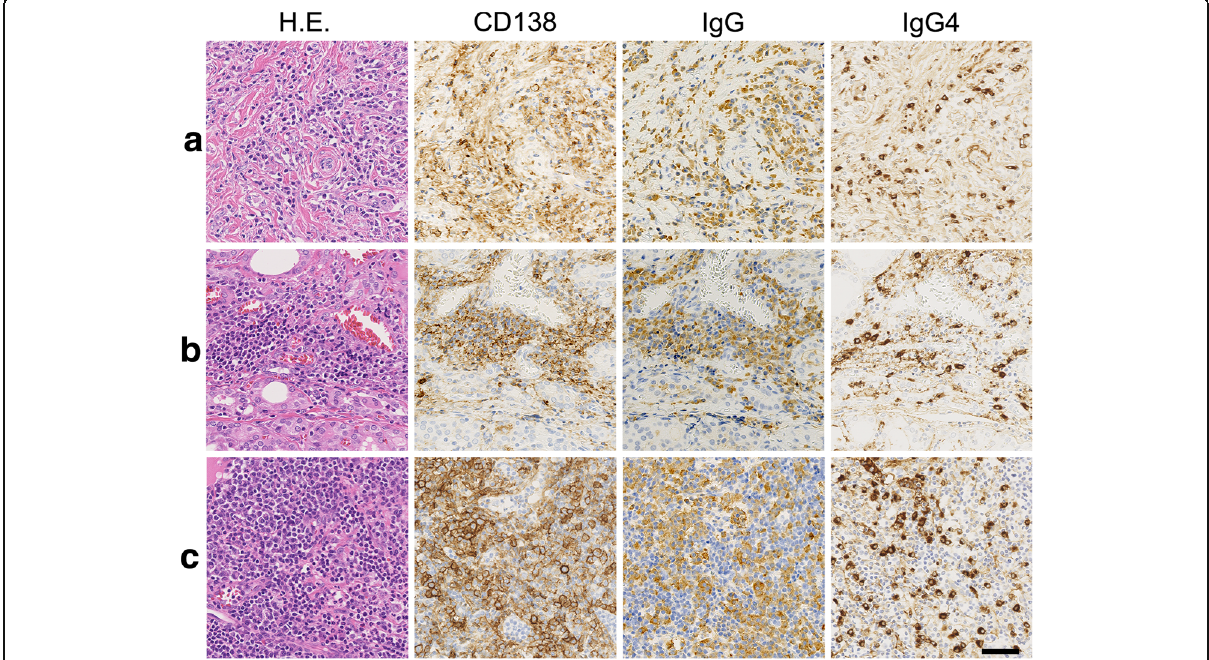
Fig. 2 Immunohistochemical findings of ( a ) lower pole ’ s mass, ( b ) background tissue in the thyroid, and ( c ) the regional lymph node. Numerous CD138 + plasma cells were infiltrated in the lower pole ’ s mass, background of thyroidal tissue, and regional lymph nodes. Most were IgG-secreting plasma cells, and 40 – 50% of them were IgG4-secreting cells. Bar = 50 μ